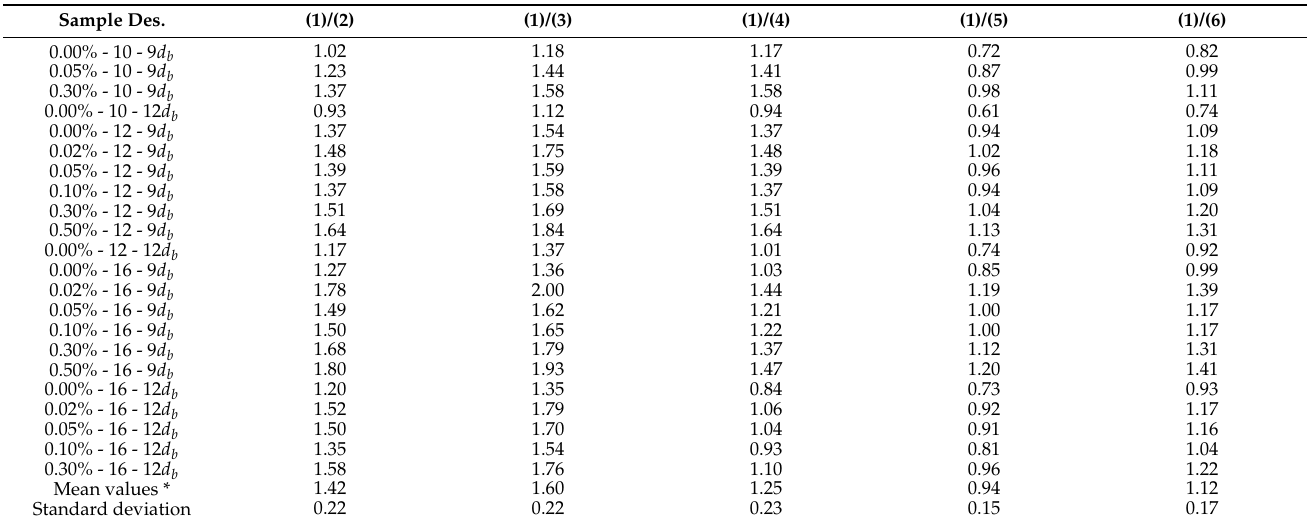
Table 9. Ratios for experimental test result/prediction of bond